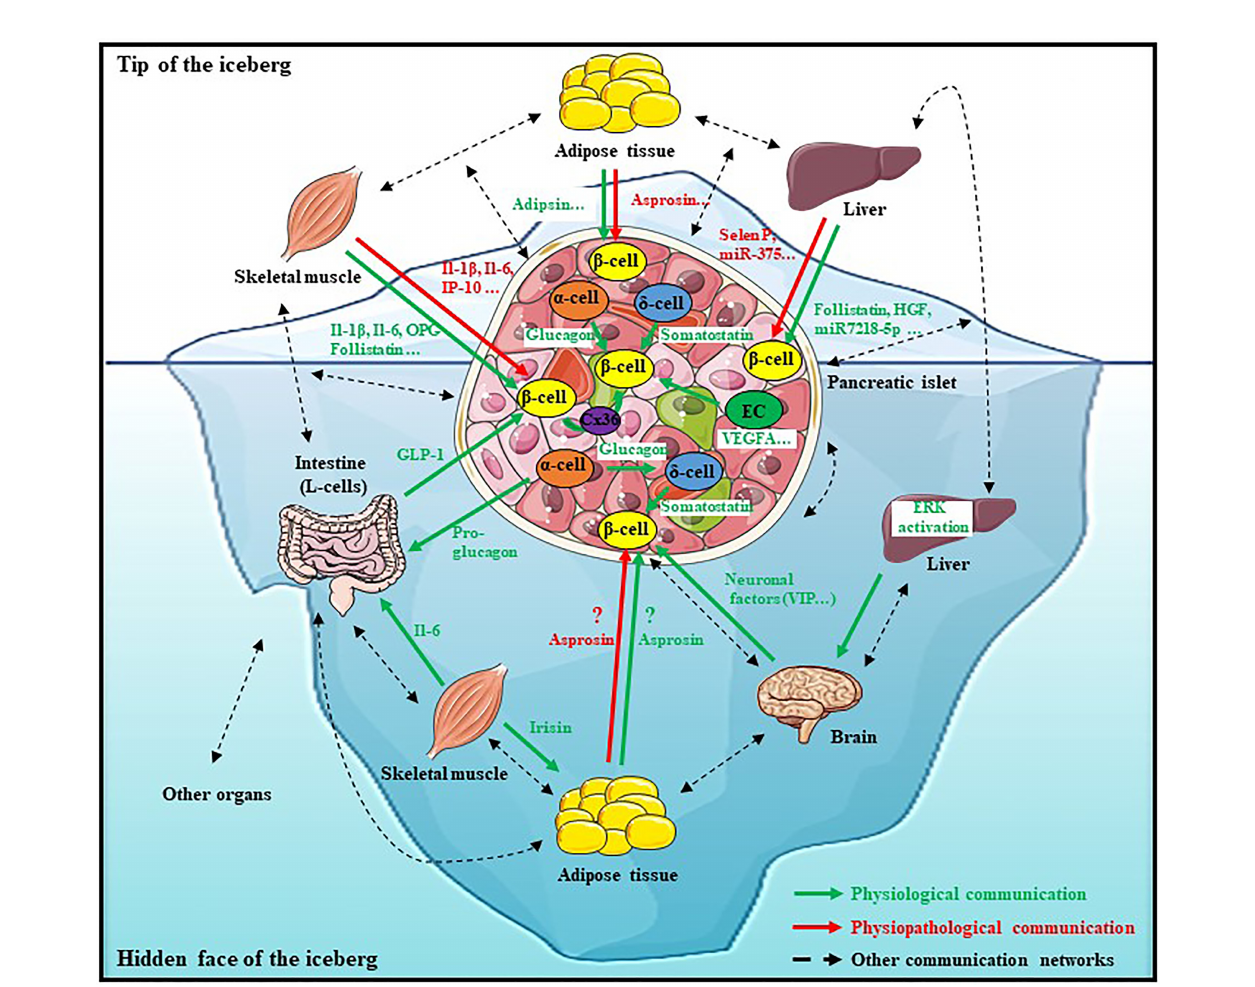
FIGURE 1 | The iceberg of b -cell ’ s communication network. The physiological b -cellular function is fi nely regulated by a dense and complex communication network including direct and indirect interactions with various cell types and organs. This communication takes place thanks to various factors secreted from many organs such as the liver, adipose tissue, skeletal muscle, intestine or even the brain which constitute a strong union to allow a physiological b -cell function. However, this description is not exhaustive, this network is more complex and should also involve other organs (Dotted black arrows). Any disturbance in this communication network can lead to dysfunction of b -cell function and to metabolic diseases such as diabetes onset. Therefore, for new anti-diabetic treatments ’ development, it is necessary to consider the entire network of cells and organs involved in the regulation of b -cellular function and no longer just the tip of the